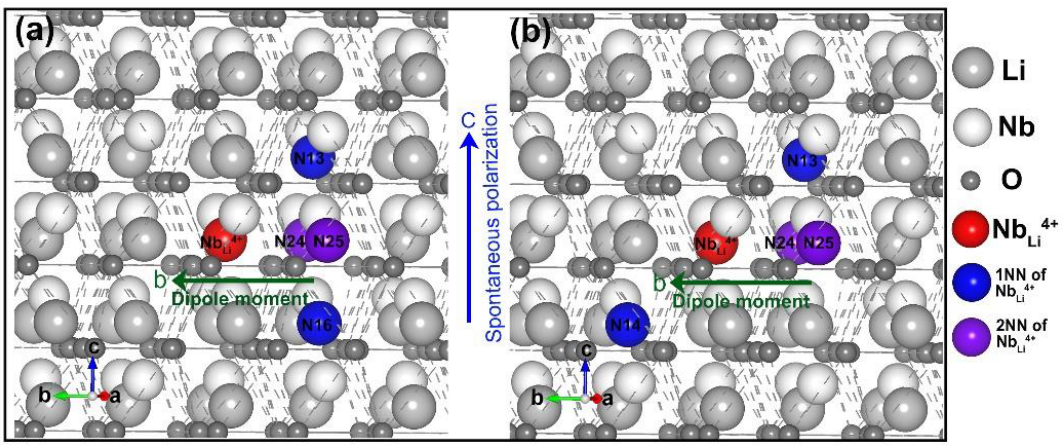
Figure 3. ( a ) The most stable model and ( b ) the second stable model of LN. The red balls present the Nb antisite. Blue and purple balls represent the lithium vacancies in 1NN and 2NN sites of Nb antisite, respectively. In addition, the blue arrow shows the direction of spontaneous polarization of the crystal, while the green arrow indicates the direction of the dipole moment.